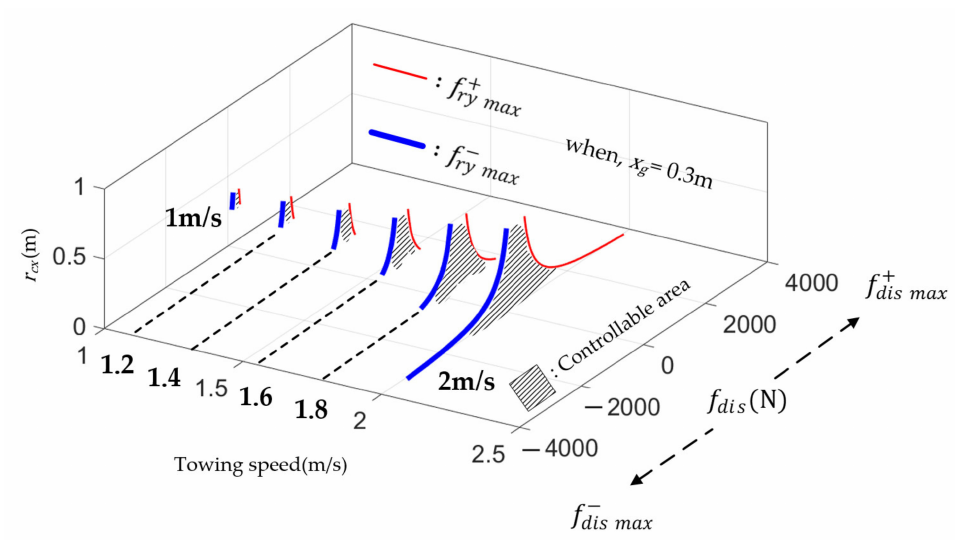
Figure 9. Allowable range of f dis when x g = 0.3 m by which yaw control can be